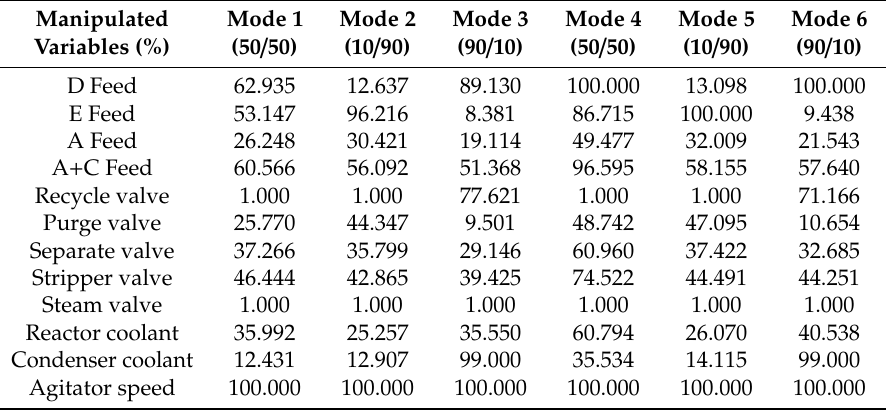
Table 2. Manipulated variables for six operating modes.